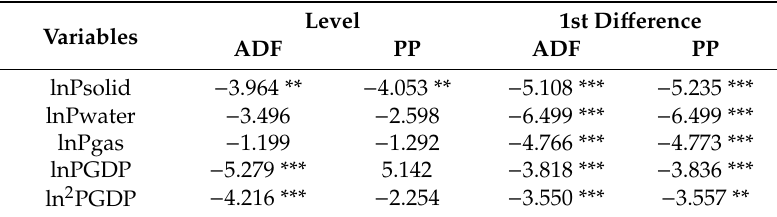
Table 4. The results of unit root